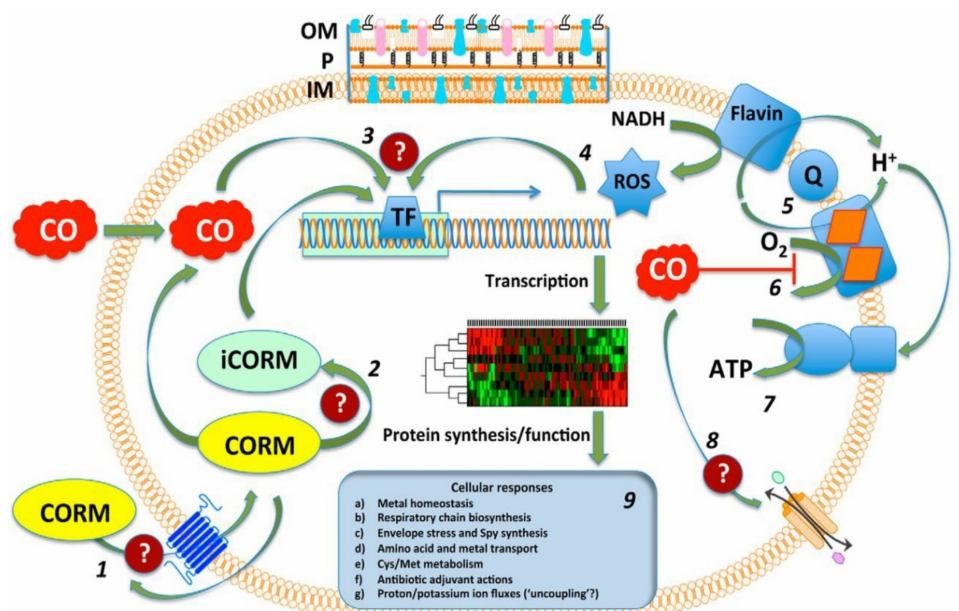
Figure 17. Modes of action and intracellular targets of CORMs. The bacterial membrane includes the inner membrane (IM), the outer membrane (OM), and periplasm (P), which are represented at the top. 1. CORMs enter bacteria by unknown pathways and mechanisms; CO enters the cells by diffusion. 2. After they enter the cell, CORMs release CO, forming inactivated CORM (iCORM). 3. CO, CORM, and iCORM are detected by transcription factors (TFs), causing transcriptional changes. 4. TFs are activated by ROS that may be generated directly by CORMs or can be generated as a result of the interaction of CORMs with the respiratory chain. 5. A simplified aerobic respiratory chain of bacteria is represented, consisting of a flavin-containing NADH dehydrogenase, a ubiquinone (Q) pool, and a terminal heme-containing quinol oxidase. 6. CO binds to the heme-containing quinol oxidase active site, competing with oxygen and impeding respiration. 7. Impairment of ATP generation by ATP synthase. 8. CO or CORM may directly or indirectly interact with IM transporters. 9. Diverse cellular responses to CO and CORM. Question marks represent unknown targets, effects, or mechanisms: transport into (or out of) cells; intracellular mechanisms of CO release from CORMs; interaction with TFs and modification of gene expression by CORMs; effects of CORMs on membrane transporters. Figure reproduced from [146].